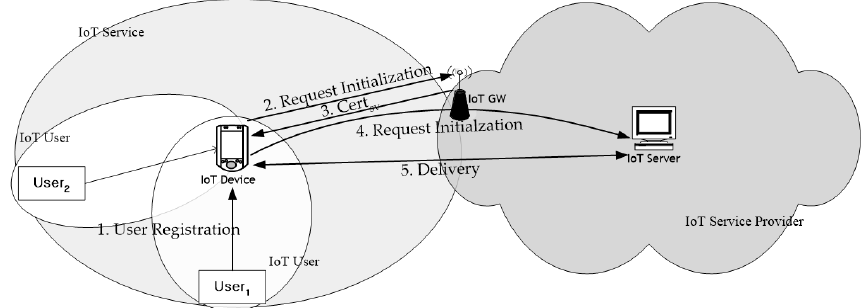
Figure 3. An example of IoT network structure and a simplified